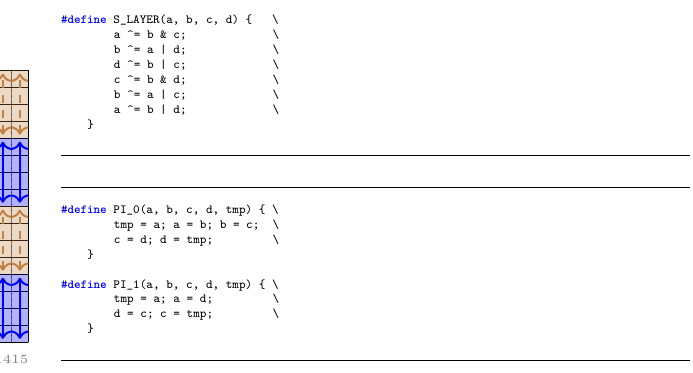
Figure 11: The application of the 4-bit S-boxes ( S ) in the register representation. 𝜎 0 is represented by continuous blue arrows, 𝜎